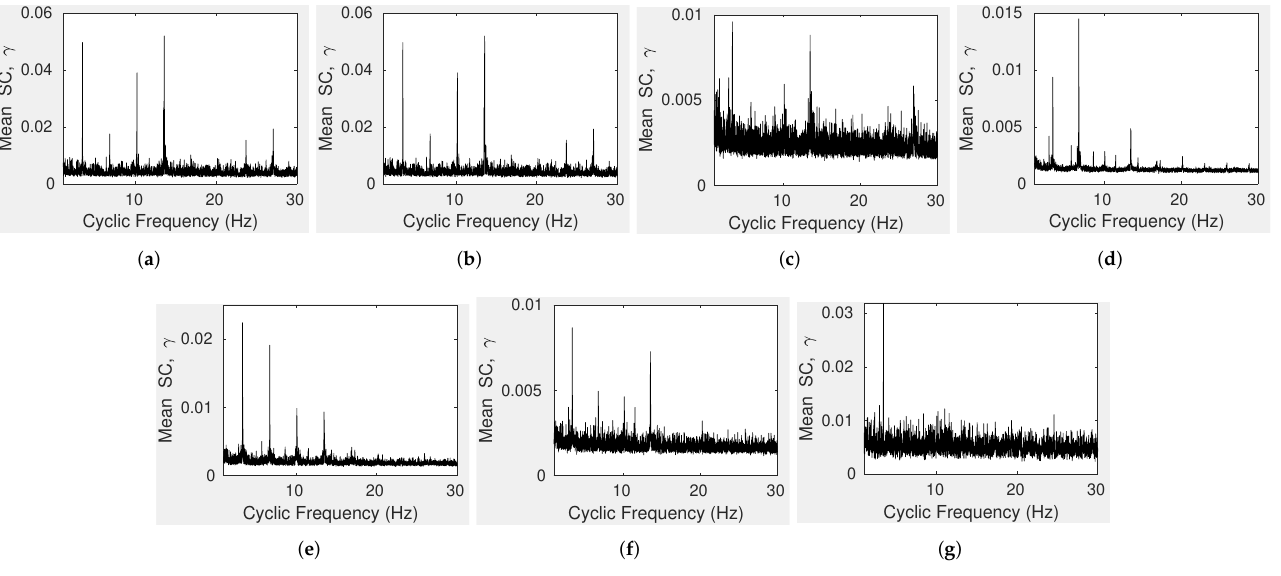
Figure 9. The mean spectral coherence (SC) γ ( α ) distributions plotted as a function of cyclic frequency α for propeller cavitation noise with pitch ratios at ( a ) 82%, ( b ) 79%, ( c ) 65%, ( d ) 51%, ( e ) 40%, ( f ) 31%, and ( g )